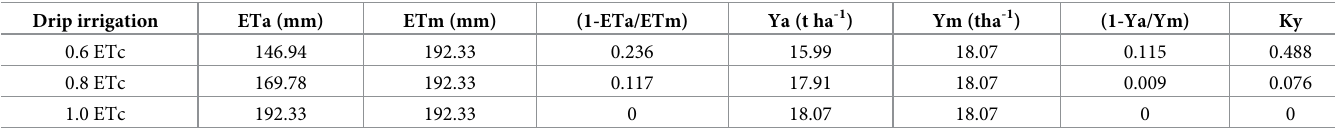
Table 5. Relationship between decrease in relative water use and decrease in relative yield for drip irrigated broccoli (average data of 3-year). Drip